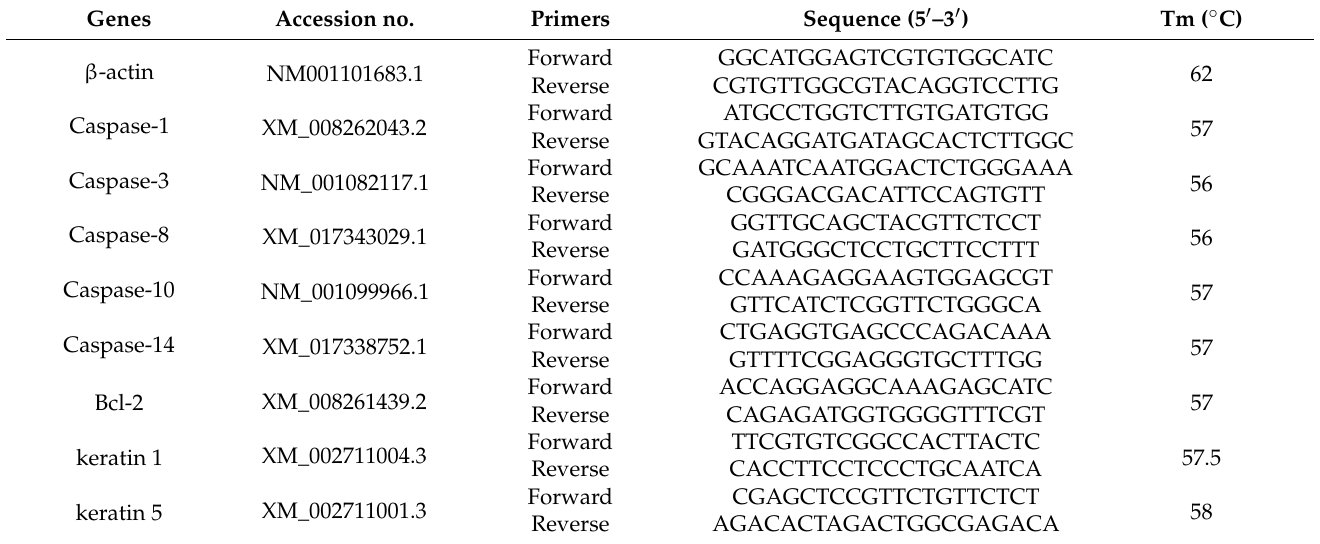
Table 2. Primer sequences used by